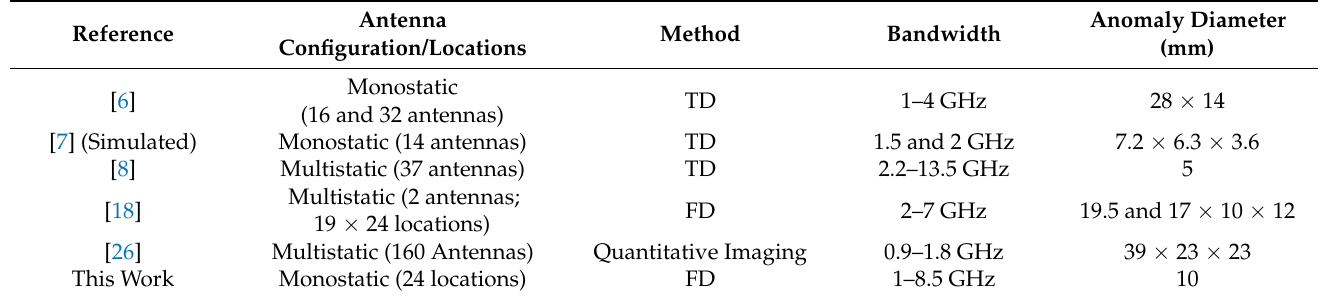
Figure 13. Measured results with a homogeneous background. The white circle shows the boundary of the background while the small black circle shows the size and location of the anomaly: ( a ) Ex- periment 1 without spatial smoothing, ( b ) with spatial smoothing, ( c ) Experiment 2 without spatial smoothing, ( d ) with spatial smoothing. Table 1. Comparison with available imaging methods and systems.